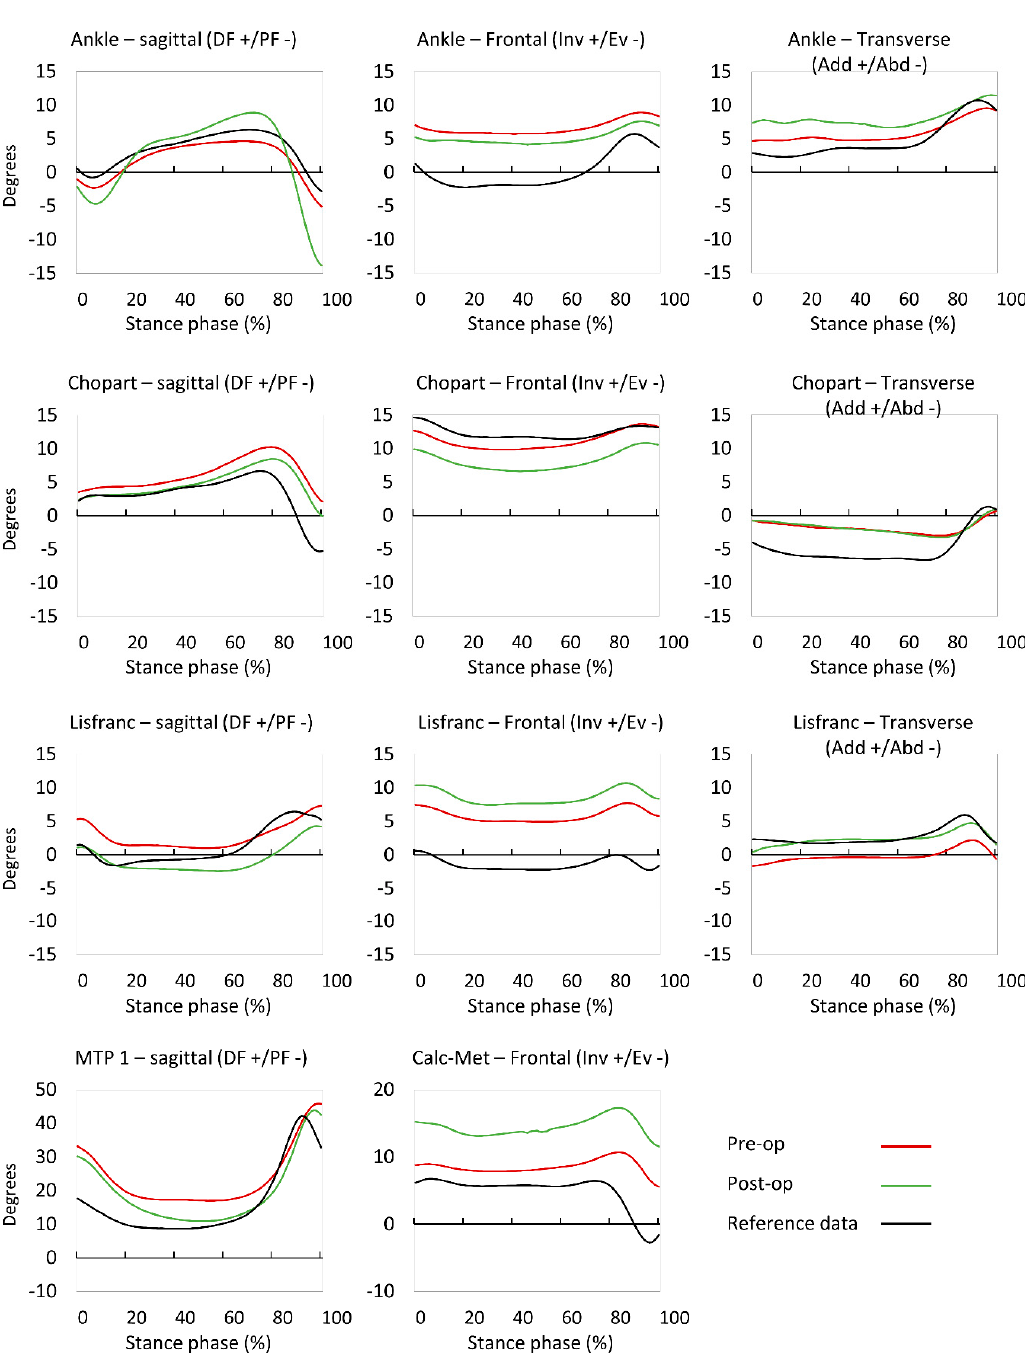
Figure 1. Control (dot/dashed line), pre ‐ operative (dashed line), and post ‐ operative (full line) kinematic waveforms of the ankle ( upper ) joint, as well as the Chopart (second row), Lisfranc (third row), and MTP 1 ( lower ) joints. PF: plantar flexion; DF: dorsal flexion; Inv: inversion; Ev: